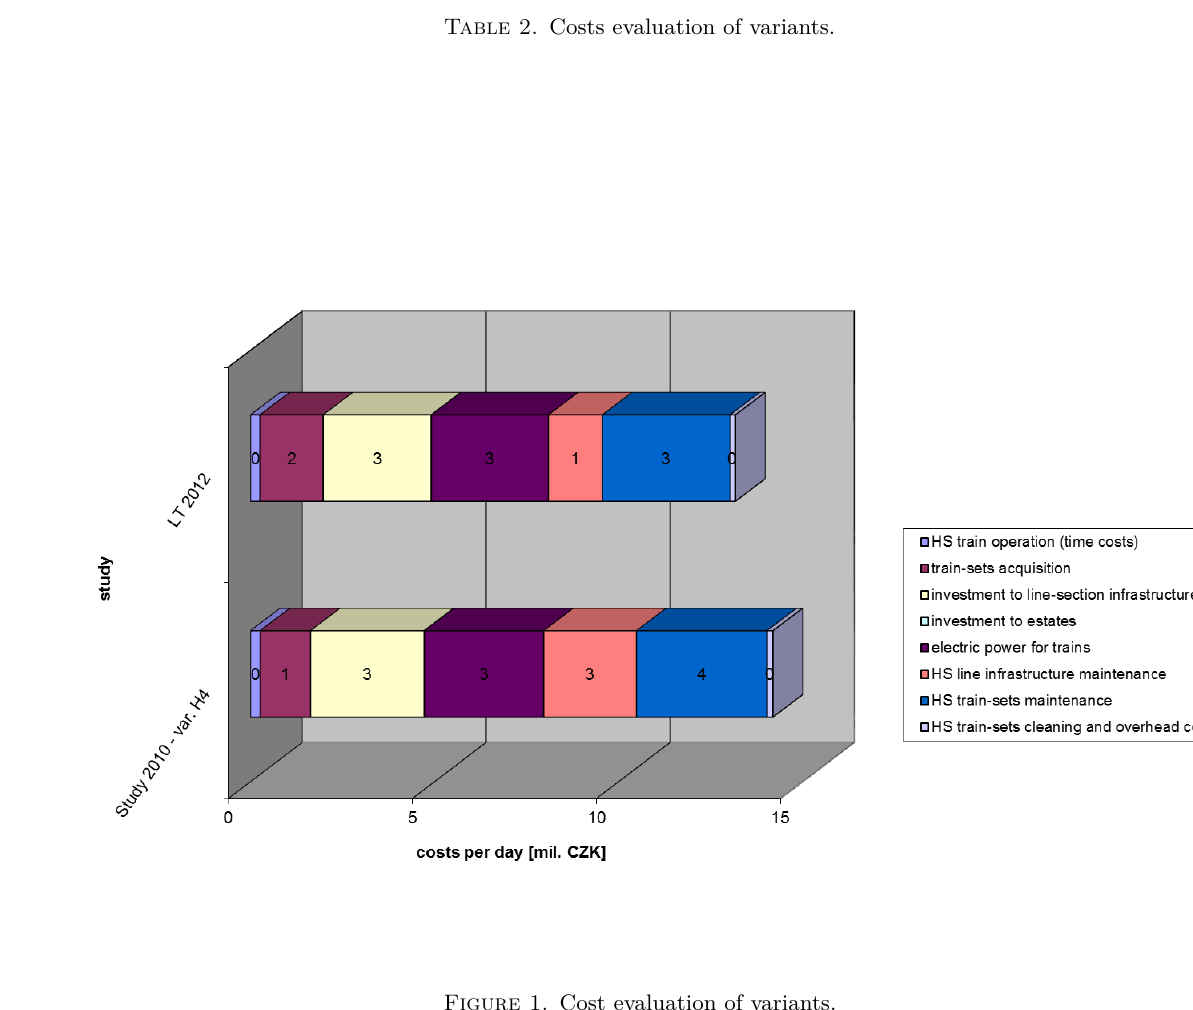
Figure 1. Cost evaluation of